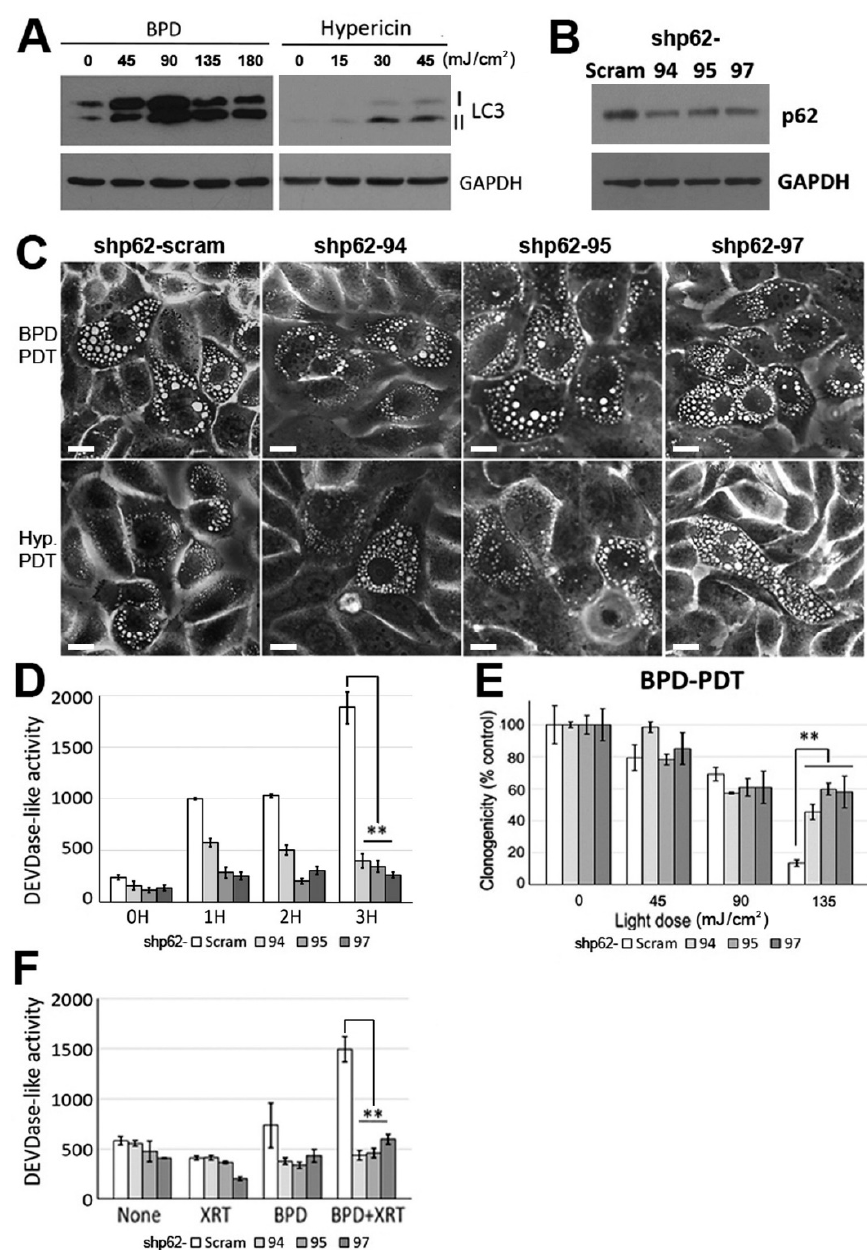
Figure 4. The autophagic adaptor p62 plays an important role in BPD-PDT-mediated apoptosis and radiosensitization. ( A ) Immunoblot analysis of LC3 in WSU12 cells at 1-day after post BPD-PDT or hypericin-PDT treatments with indicated light doses. ( B ) Immunoblot analysis of p62 in control (Scram) and p62 knockdown WSU12 cell lines (shp62–94, shp62–95 and shp62–97). ( C ) Phase contrast images of paraptotic cells in control and p62 knockdown WSU12 cells at one day after BPD-PDT at 90 mJ/cm 2 or hypericin-PDT at 45 mJ/cm 2 . Scale bar, 20 μ m. ( D ) DEVDase activity in control and p62 knockdown WSU12 cells upon BPD-PDT at 90 mJ/cm 2 . (** p < 0.01). ( E ) Clonogenic cell survival of control and p62 knockdown WSU12 cells upon BPD-PDT. (** p < 0.01). ( F ) DEVDase activity was measured at 4 h after treatments with/without XRT at 2 Gy and/or BPD-PDT at 180 mJ/cm 2 . (** p < 0.01).